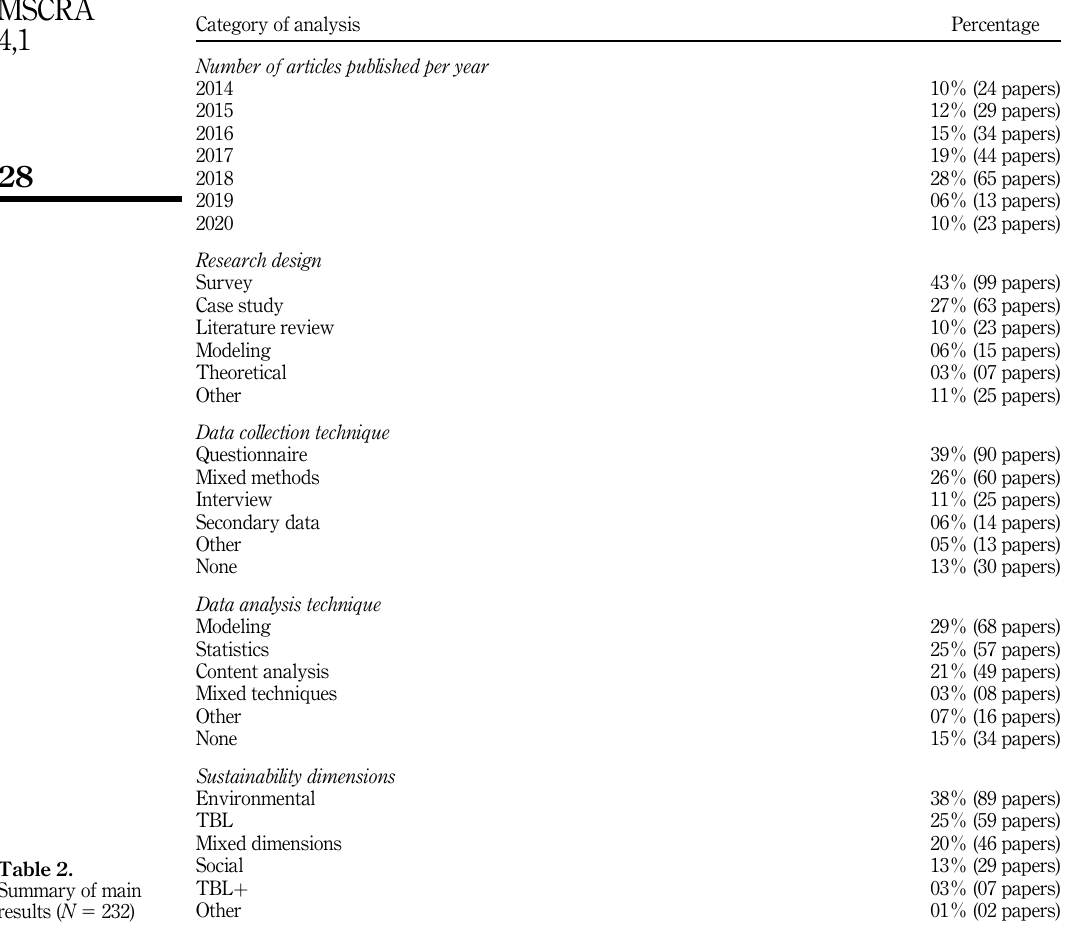
Table 2. Summary of